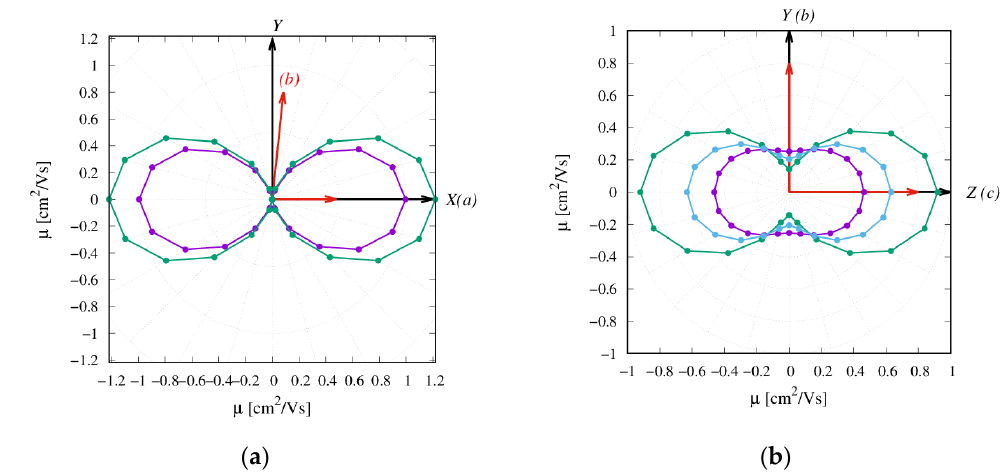
Figure 6. Anisotropy of charge transport from TOF KMC simulations for ( a ) α-NDTI and ( b ) N-NDTI . Purple represents ANTI-1 , green represents ANTI-2 , and cyan represents the mix .